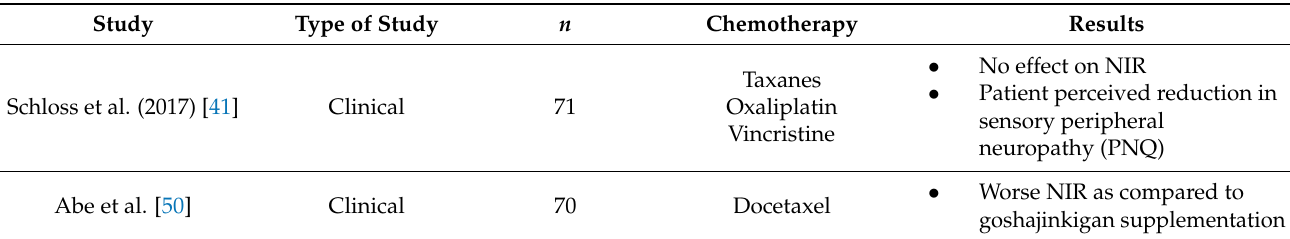
Table 2. Efficacy of vitamin B group in